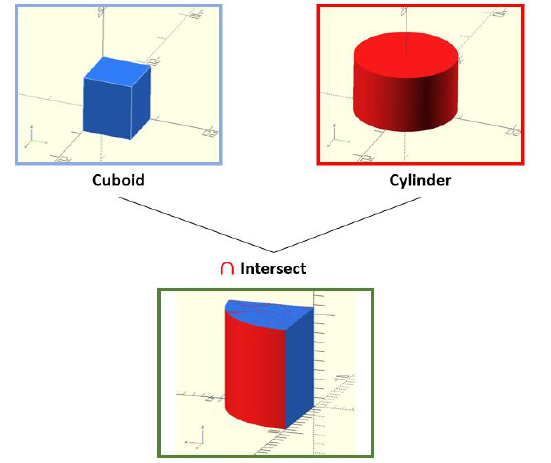
Table 4 . Modelling energy efficiency protection and overshadowing open space LuRs based on their identified